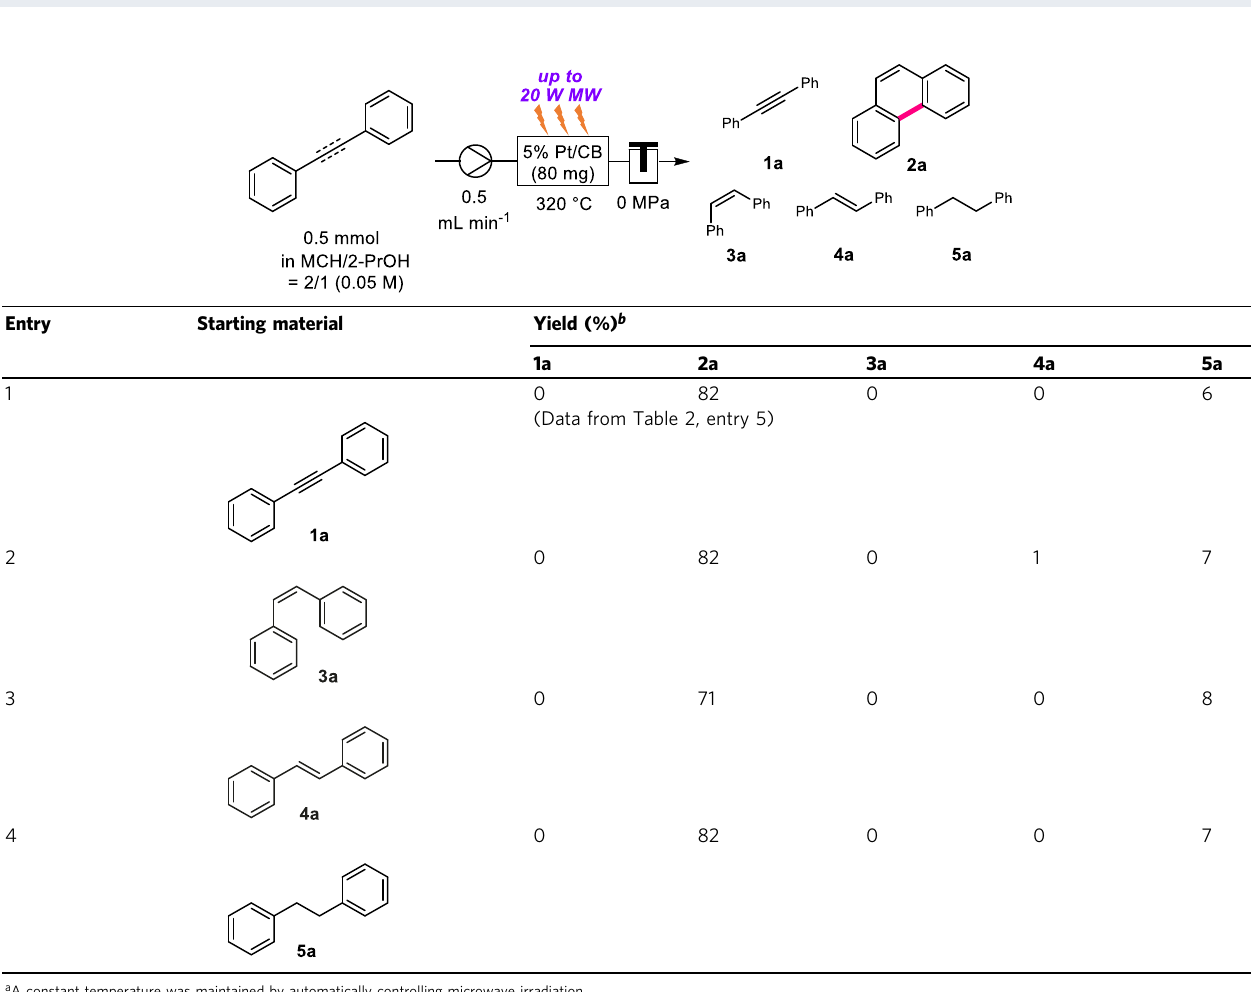
Table 3 Mechanistic investigations a .